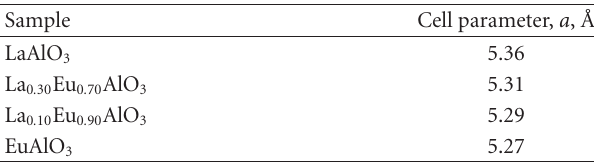
Table 2: Cell parameter of europium containing